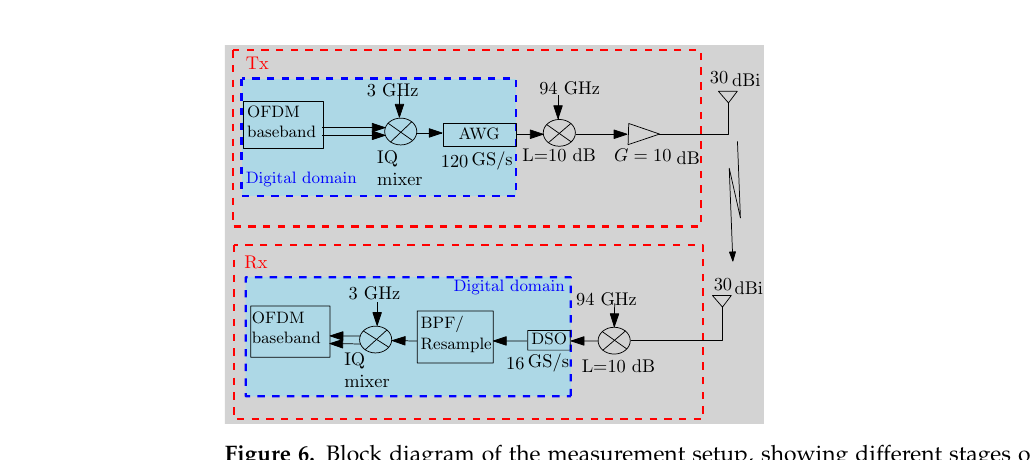
Figure 6. Block diagram of the measurement setup, showing different stages of processes in the digital and analog domains at the transmitter T X and the receiver R X .